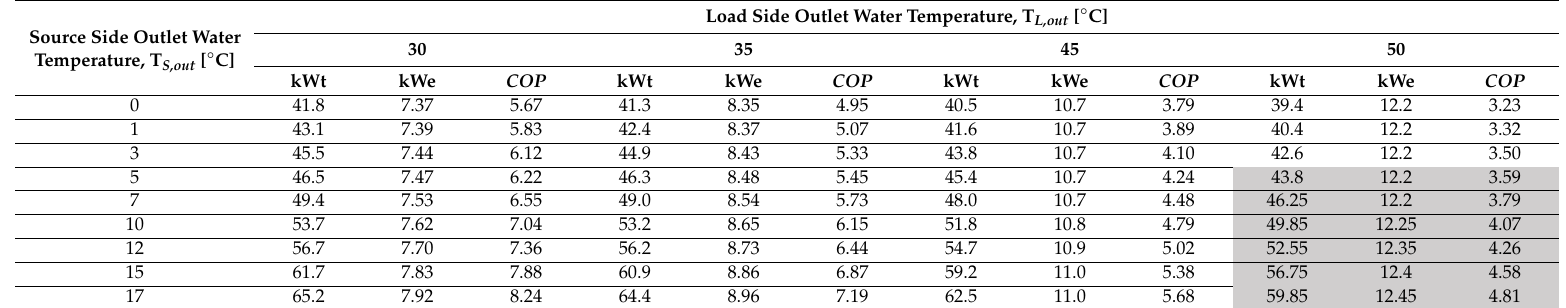
Table 2. Manufacturer Data for reversible heat pump. The data are from Clivet manufacturer for HP model WSHN-XEE2. Heating Mode. Source Side Outlet Water Temperature, T S,out [ ◦